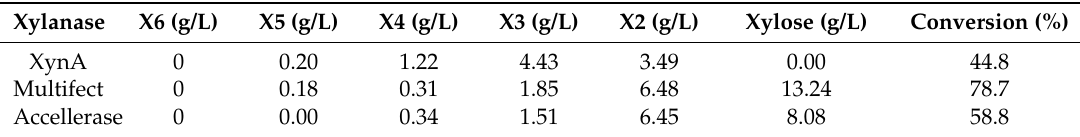
Table 3. Composition of xylooligosaccharides (XOS) after enzymatic hydrolysis ofbirchwood